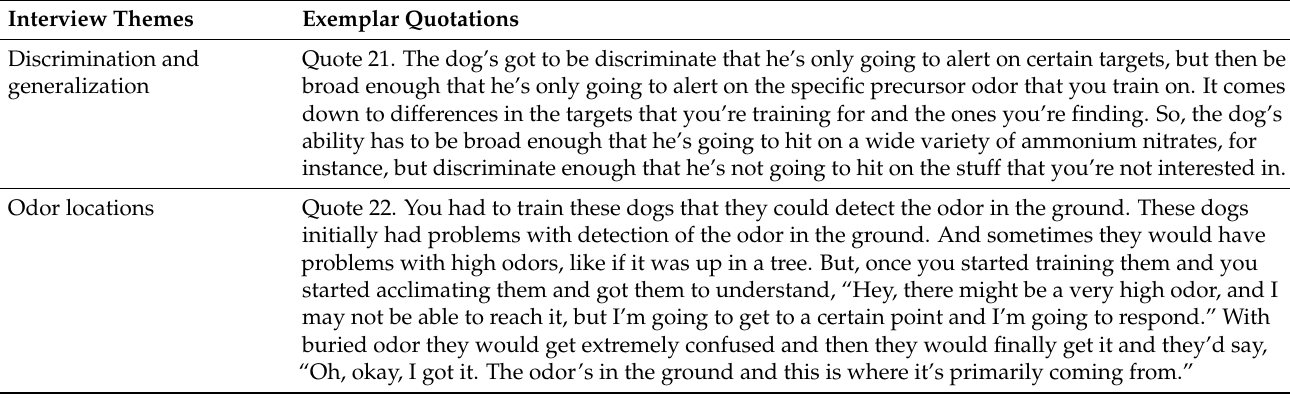
Table 6. Explosive odor environment interview themes and exemplar